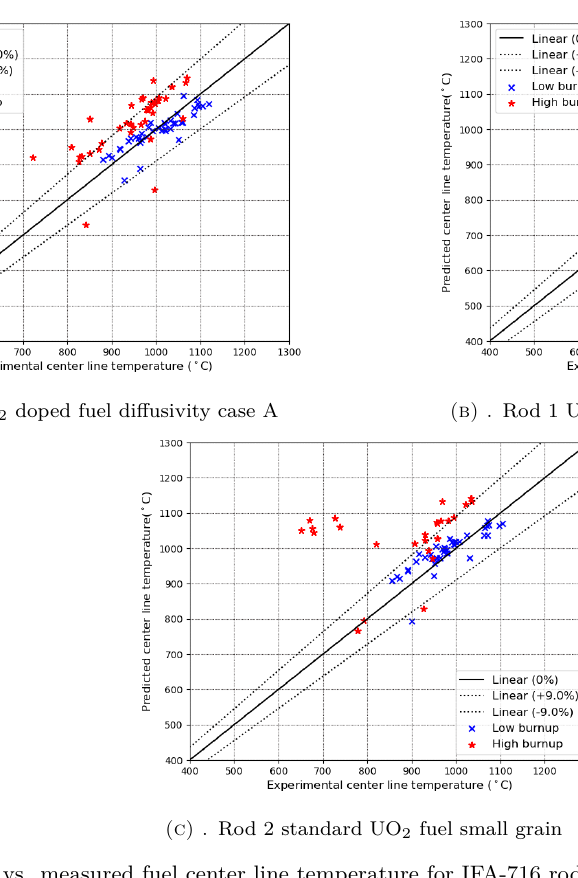
Figure 7. Predicted vs. measured fuel center line temperature for IFA-716 rods 1 and 2. For burnup lower than 17 MWd/KgUO 2 (shown as ’ (cid:53) ’) and burnup higher than 17 MWd/KgUO 2 (shown as ’ ? ’).